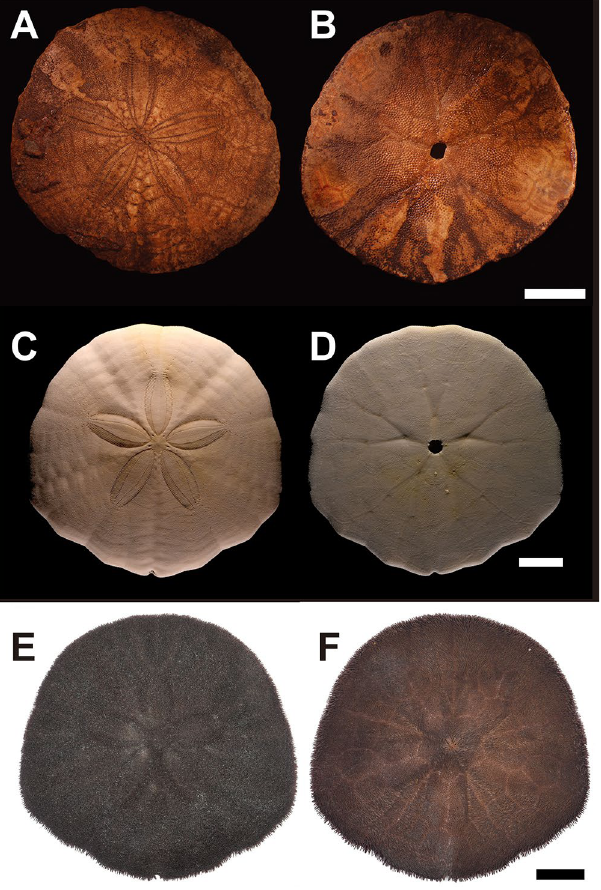
Figure 1. Fossils and living Scaphechinus mirabilis A. Agassiz, 1864. Scale bars = 10 mm. Aboral views ( A , C , E ); oral views ( B , D , F ). ( A , B ) Fossil specimens (C10), Pleistocene, Miaoli, Taiwan. ( C , D ) Denuded modern specimen (SM002) used for clumped isotope analyses (Fig. 3B). ( E , F ) Living specimen (SM100) with intact spines. Figure was created with CorelDRAW X7 Graphic (https:// www. corel draw. com/ en/ produ ct/ corel